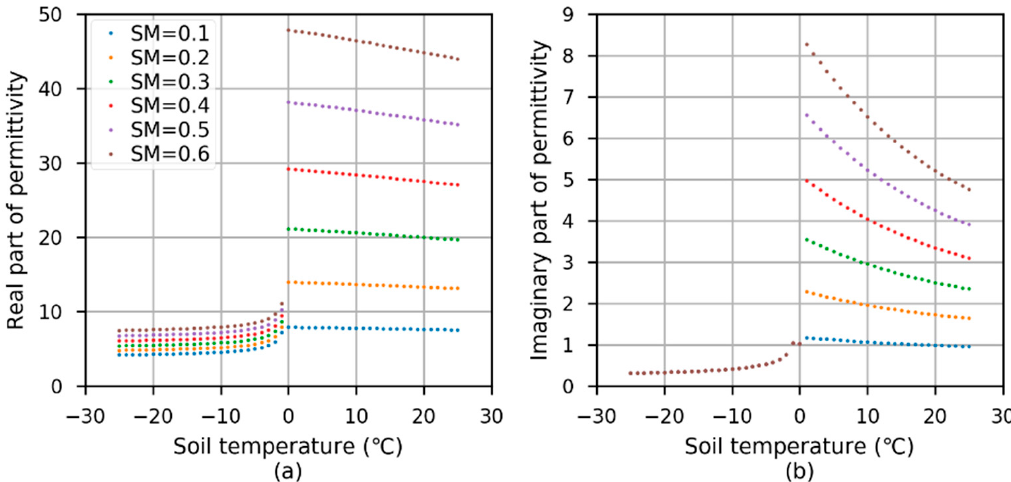
Figure 1. The relationship of the real part ( a ) and imaginary part ( b ) of permittivity and soil temperature under di ff erent soil moisture contents. SM stands for soil moisture, while its unit is cm 3 / cm 3 . Soil texture for the simulations is: sandy percentage is 51.5 %, clay percentage is 13.5 %, while the bulk density is 1.60 g / cm 3 .